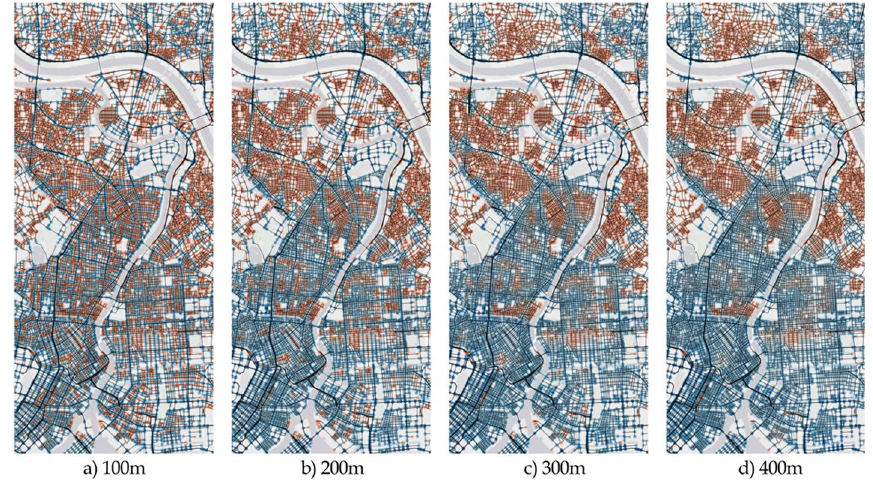
Fig. 2 The normalized percents of sidewalk coverage for each node’s subgraph at varying subgraph sizes (blue is more coverage). Larger subgraphs tend to increase the similarity of neighboring nodes, thus smoothing the spatial distribution of attribute